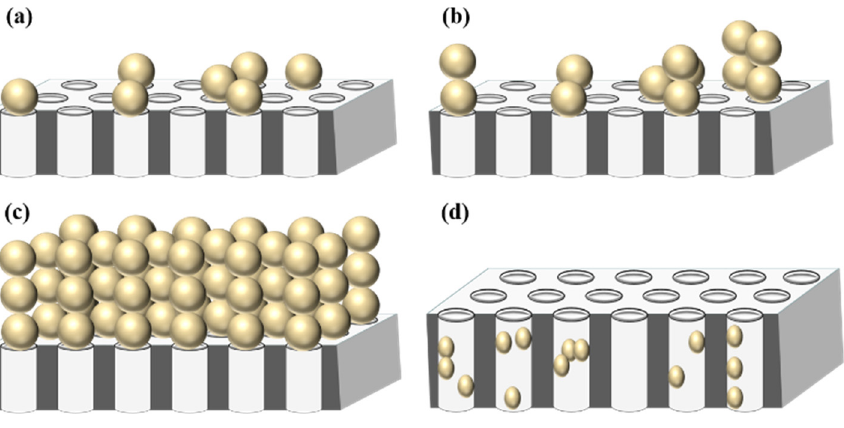
Figure 3. Schematic representation of Hermia’s fouling mechanisms: ( a ) Complete pore blocking; ( b ) Intermediate pore blocking; ( c ) Cake filtration; and ( d ) Pore filling. The values of the fouling index n associated with mechanisms ( a ) to ( d ) are, respectively, 2, 1, 0 and 1.5. Adsorption is not included. Reproduced with permission from [37]. Copyright 2022 Elsevier.